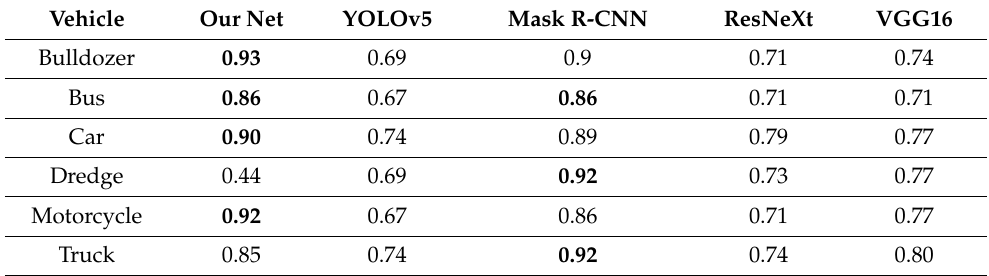
Table 3. Comparison of F1 scores for each class. The best indicators for each class are highlighted in bold.